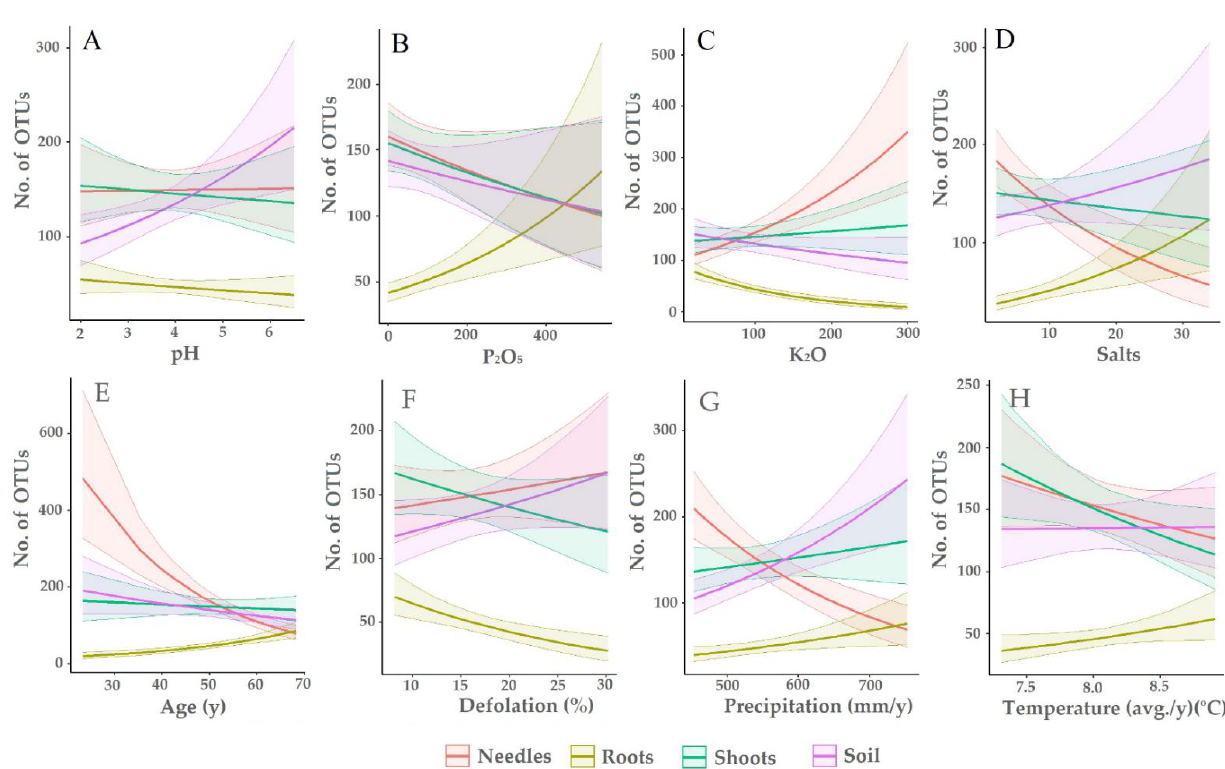
Figure 4. The relationship between the richness of fungal OTUs in different substrates (needles, shoots, roots, and the soil) of Picea abies and soil pH ( A ), P 2 O 5 ( B ), K 2 O ( C ), salts ( D ), stand age ( E ), tree defoliation ( F ), yearly precipitation ( G ) and average yearly temperature ( H ). The semitransparent field around each curve denotes the size of deviation from the mean value.